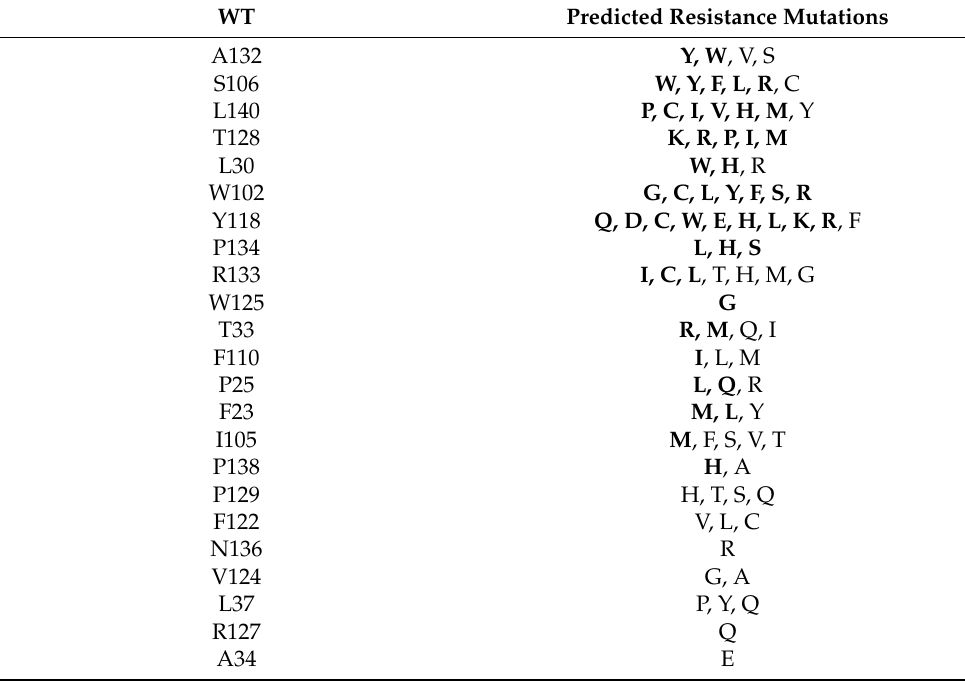
Table 2. List of predicted resistance mutations in HBV core protein for GLP-26.